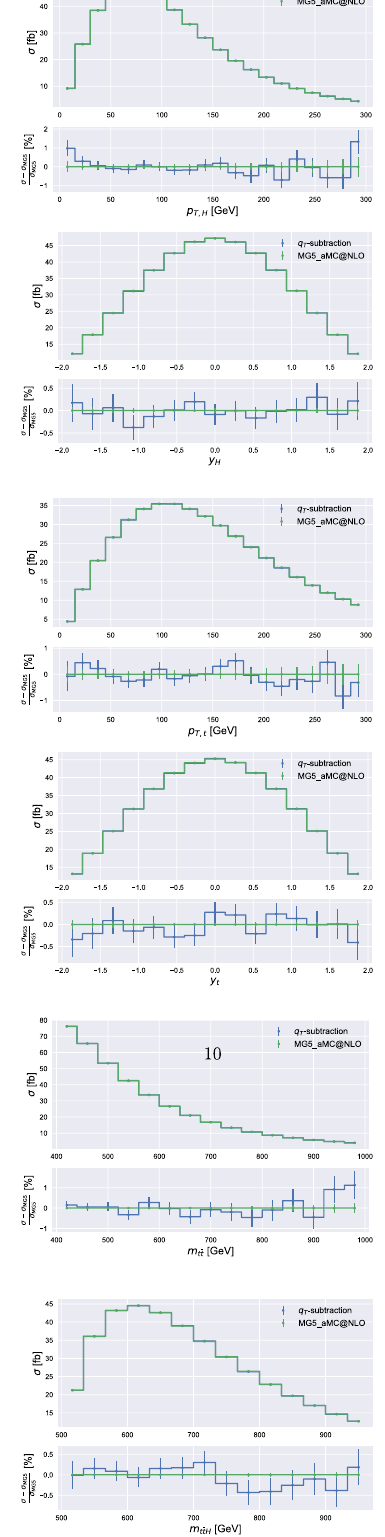
Fig. 2 The NLO results of Madgraph5_aMC@NLO for the cross section dependence on several kinematic variables at The lower panels show the relative comparison with the corresponding results obtained by using q T